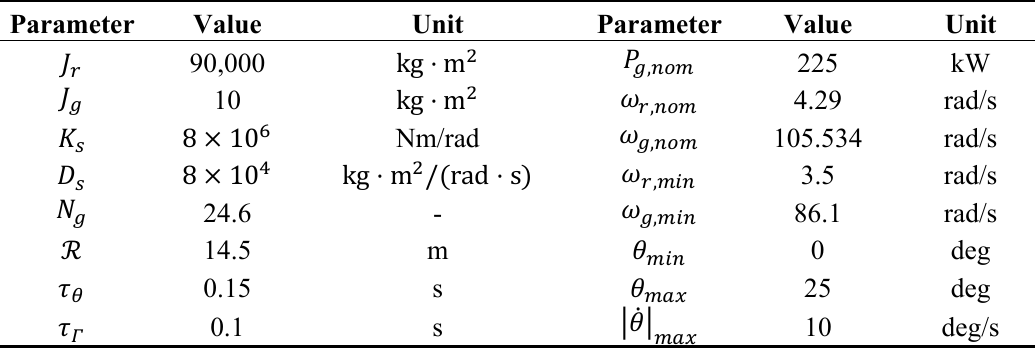
Table 1. Model parameters.